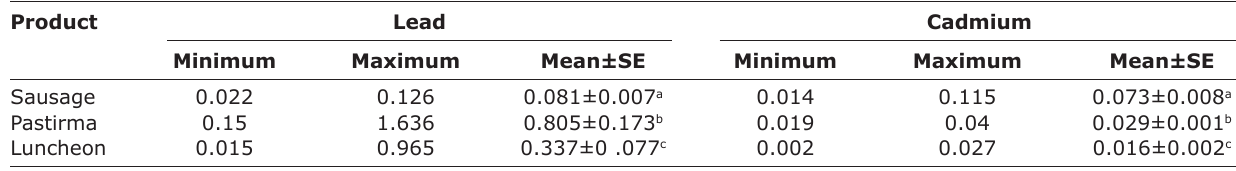
Table-2: The concentration (ppm) of lead and cadmium in different meat products. Product